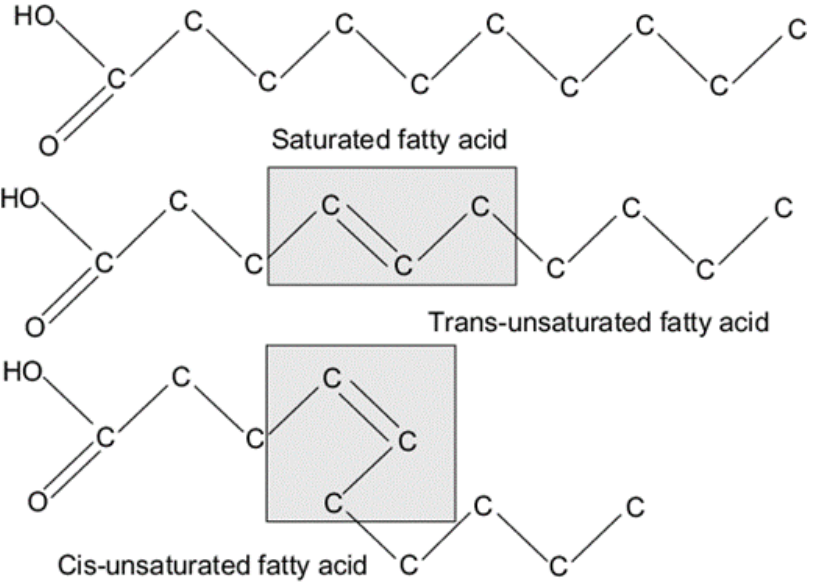
Figure 3. Molecular structure of different types of fatty acids. This figure was redrawn based on [43]. A list of common fatty acid PCMs with their respective thermo-physical properties is given in Table 3. Table 3. Thermo-physical properties of different fatty acids.